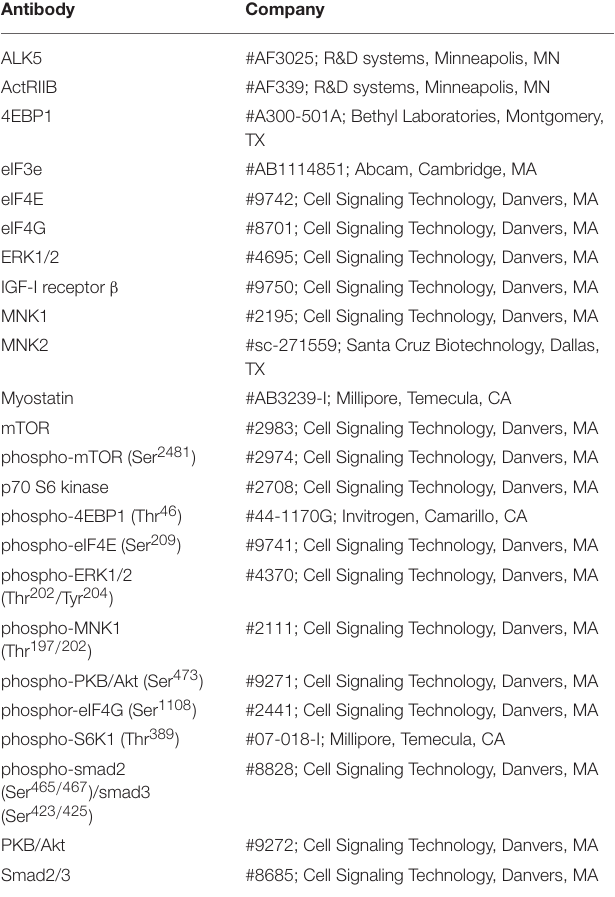
TABLE 2 | Information of primary antibodies used for western blot.